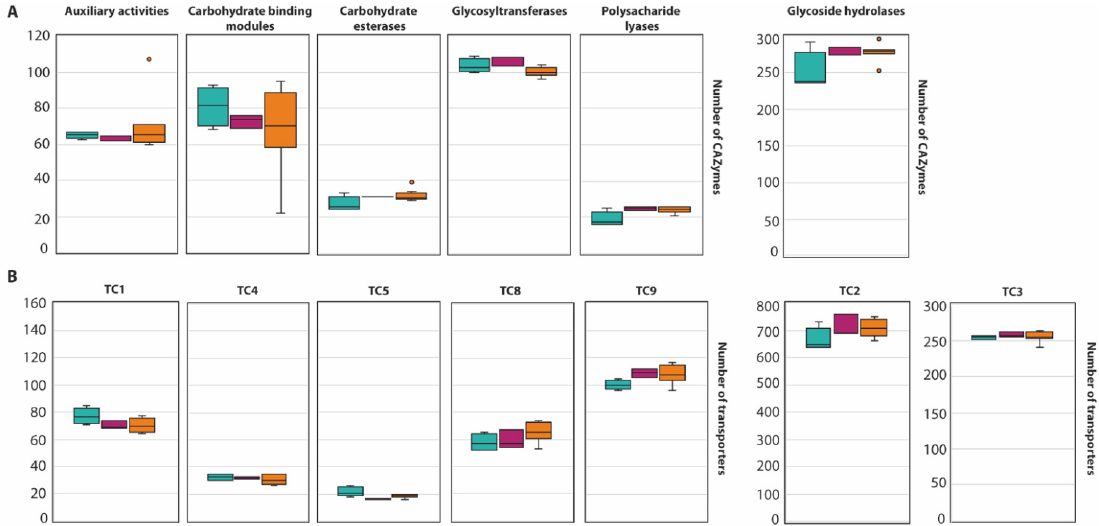
Figure 3. Boxplot representing the diversity of CAZyme family ( A ) and the abundance of transporters ( B ) in the section Circumdati : series Sclerotiorum (blue), series Steyniorum (pink) and series Circumdati (orange). In the boxplot, the midline represents the median and the upper and lower limit of the box represents the third and first quartile. One way analysis of variance (ANOVA) followed by Student t -test was used. No significant differences ( p > 0.05) were observed.